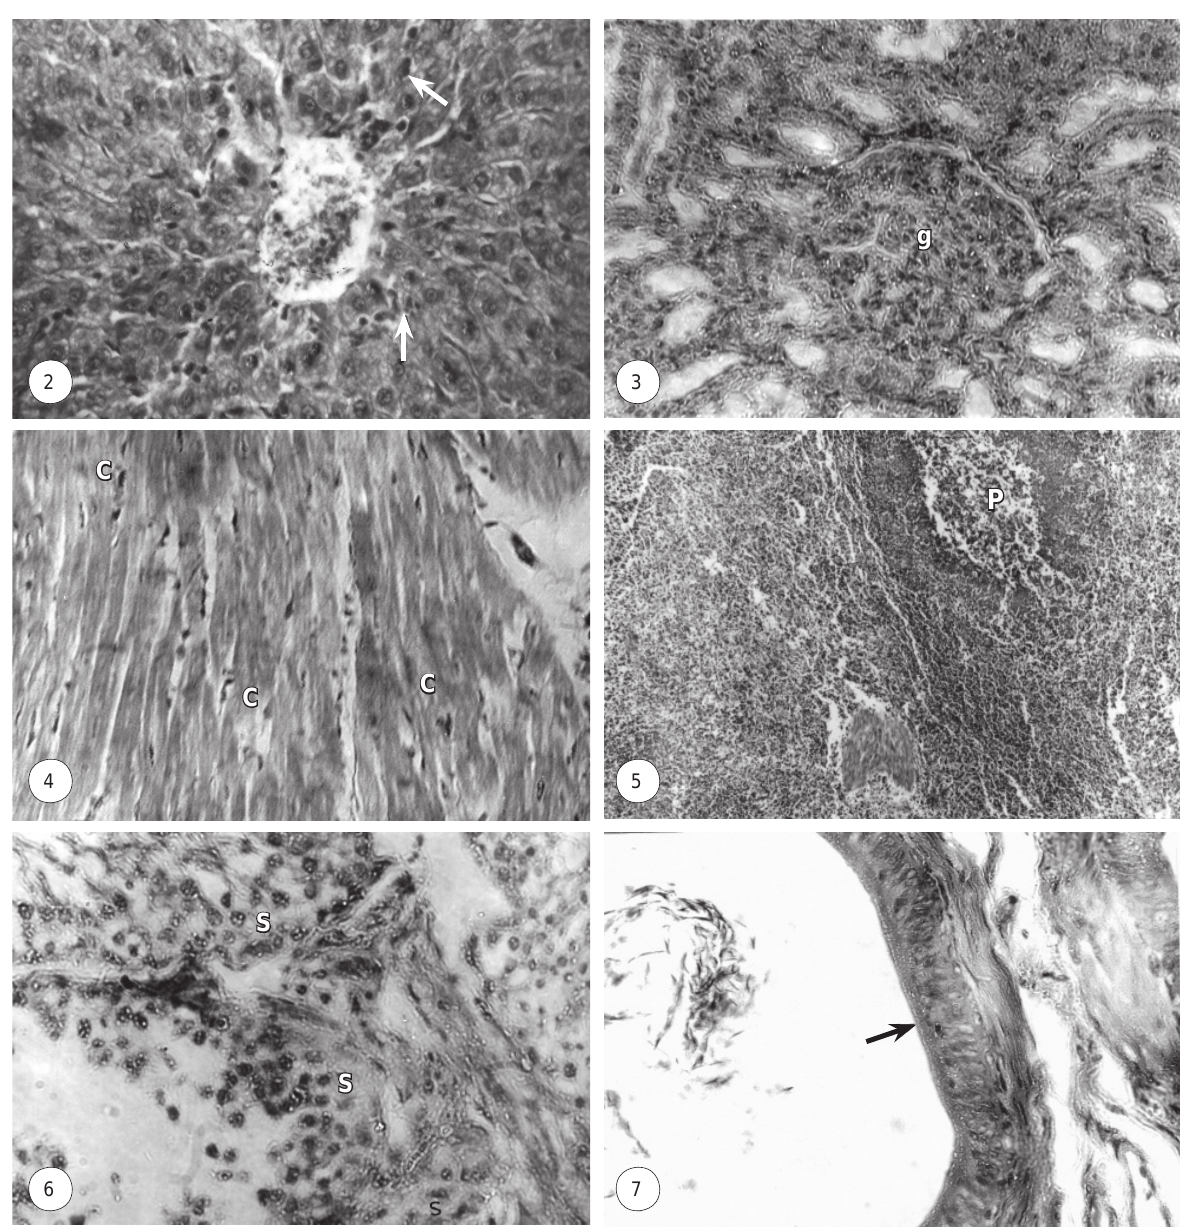
FIG. 2 Photomicrograph of liver from a T. vivax -infected bull not infused with lactose. Note erythrophagia by Kupffer cells (arrows) and fatty change. H & E; X357 FIG. 3 Photomicrograph of kidney of a T. vivax-infected bull, not infused with lactose. The Bowman’s space is obliterated as a result of a proliferation of the mesangium of the glomerulus (g). H & E; X300 FIG. 4 Photomicrograph of the heart of a T. vivax -infected, uninfused bull, showing degeneration of myocardial fibres (c). H & E; X300 FIG. 5 Photomicrograph showing the spleen of a T. vivax -infected, uninfused bull. There is depletion of lymphoid cells from white pulp nodule (P). H & E; X105 FIG. 6 Photomicrograph of the testis of a T. vivax- infected, uninfused bull, showing degeneration of interstitial cells and spermato- genic cells (S) in seminiferous tubules. H & E; X357 FIG. 7 Photomicrograph of the epididymis of a T. vivax- infected, uninfused bull. Note absence of microvilli (stereocilia) on the epi- thelial surface (arrow) and decreased sperm reserve. H &